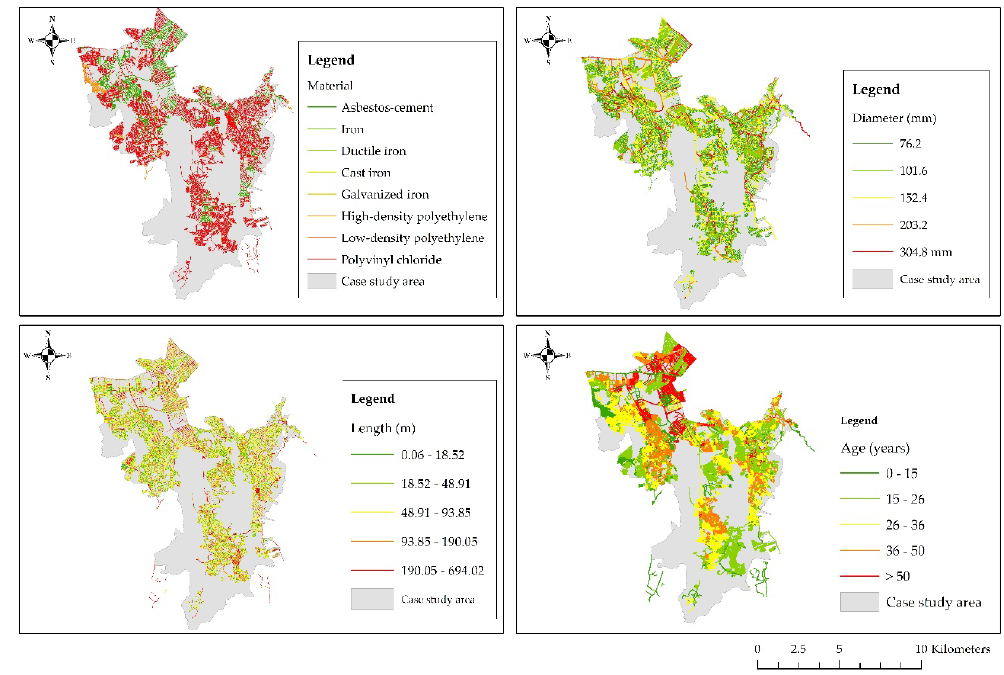
Figure 2. Case study area in southern Bogotá (Colombia).